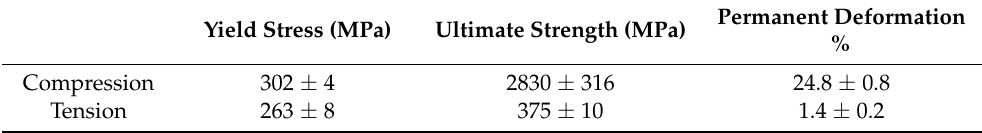
Figure 8. Tension test diagrams are compared with the results of compression tests. Table 4. Mechanical properties of specimens during the tension and compression